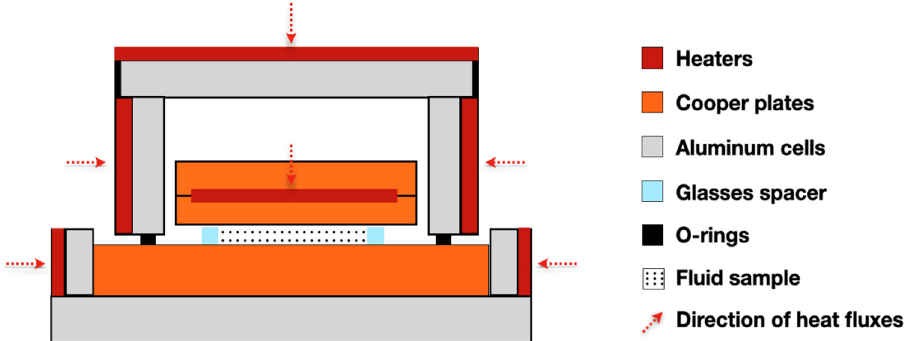
Figure 5. Illustrative scheme of the steady-state parallel-plate method.